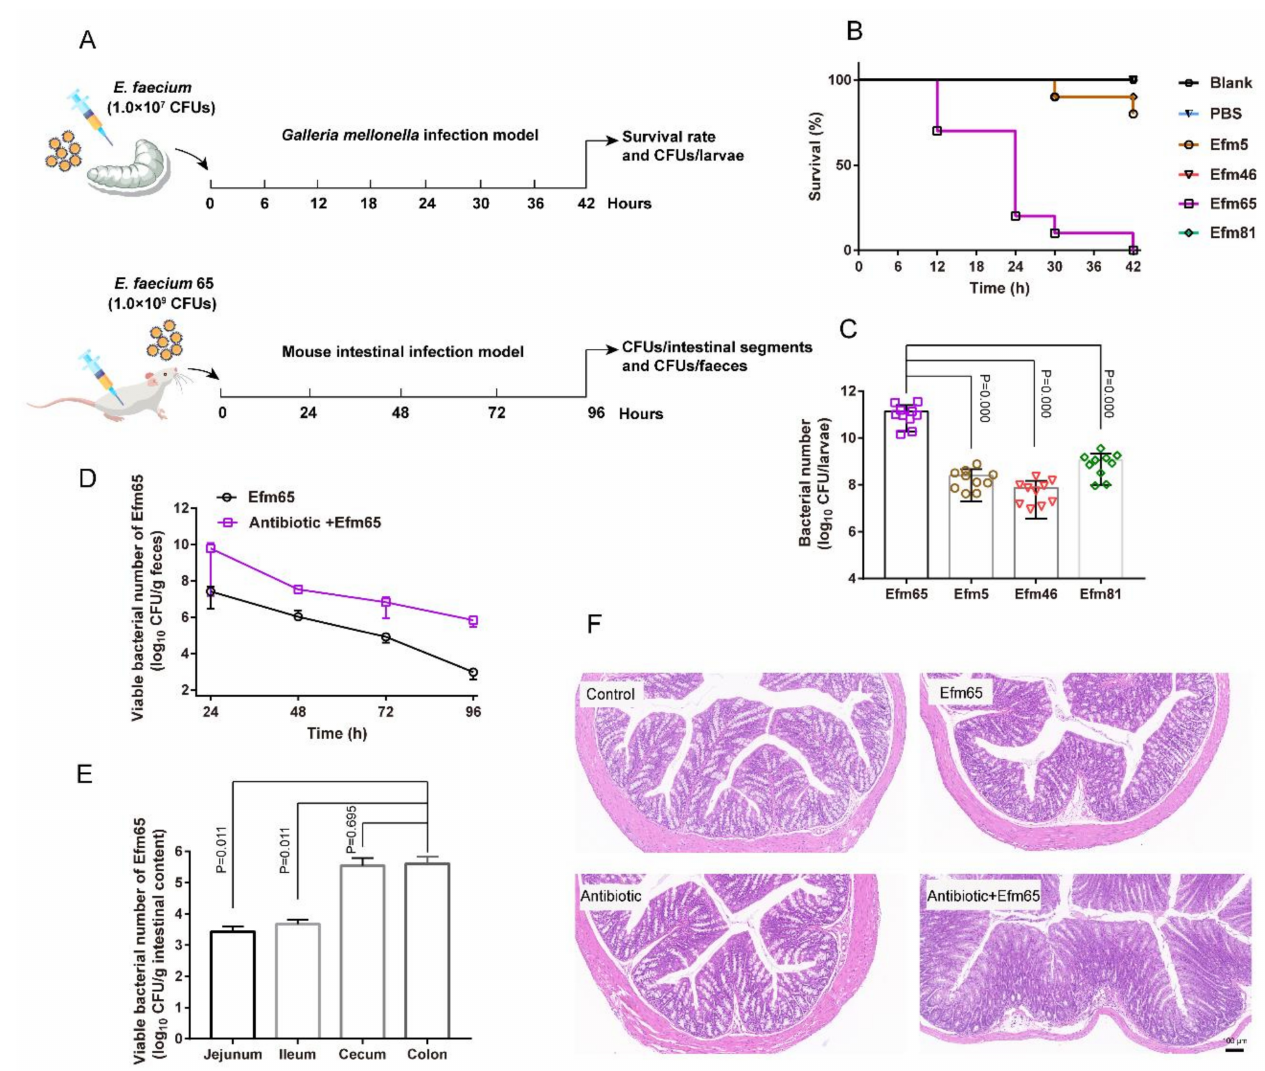
Figure 5. Toxicity evaluation of probiotic enterococcal isolates in vivo. ( A ) Scheme of the experimental protocol for the G. mellonella infection model and mouse intestinal infection model. ( B ) Survival rates of G. mellonella larva. Infected larvae (n = 10) with enterococcal isolates (10 7 CFUs/larva). ( C ) The number of enterococci in G. mellonella posts 42 h infection. ( D ) Colonization of the Efm65 in the intestine of mice. ( E ) The number of the Efm65 colonized different mouse intestinal segments. ( F ) The morphology of mouse colonic tissues in different treated groups. Differences in C and E were statistically analyzed by one-way ANOVA. p ≤ 0.05 was considered to be